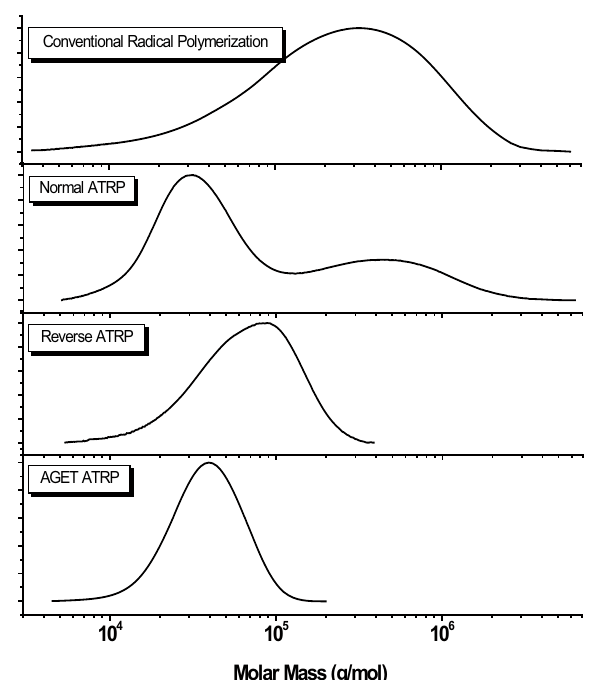
Figure 2. Typical GPC traces of the polymers from conventional radical polymerization, normal ATRP, reverse ATRP, AGET ATRP of MMA in microemulsion [76]. Reproduced with permission from the American Chemical